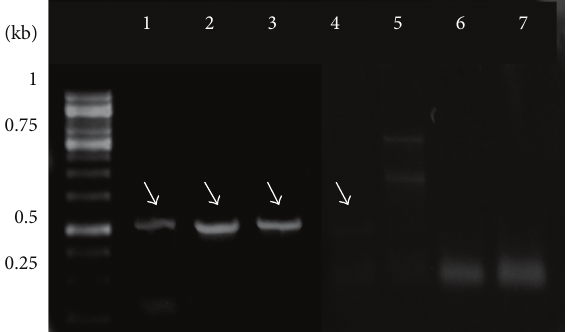
Figure 4: PCR amplification of the fragile sites located at the Ste- 20 gene locus present on chromosome VIII of S. cerevisiae . Lane 1: band of the mol. wt. 613bp corresponding to Ste-YF1, lane 2: 529 bp bandrepresentingSte-YF2,lane3:531 bpbandcorrespondingtoSte- YF3, lanes 6 and 7: control, and lane 4: band of mol. wt. 487 bp representing Ste-YF4. M is the 100bp molecular wt marker and L is the 1kb DNA ladder.